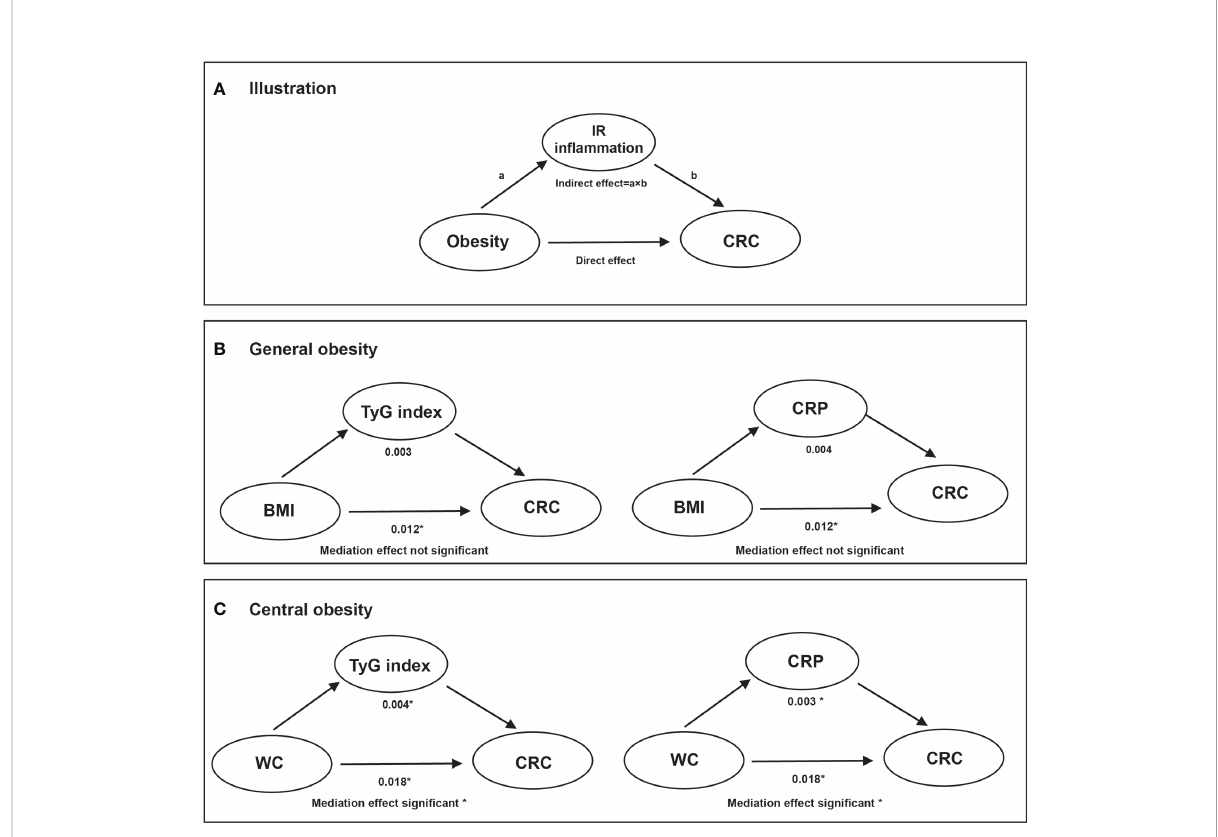
FIGURE 3 The mediation effect of TyG index and CRP on the association of obesity with CRC risk. Note: Adjusted models were adjusted for age (every 10 years), sex, family income, educational background, marital status, WC, TC, smoking status, drinking status, physical activity, sedentary lifestyle, tea consumption, salt intake, high fat diet, hypertension, and family history of cancer. (A) : illustration; (B) : overall obesity; (C) : central obesity. * Values were statistically signi fi cant.